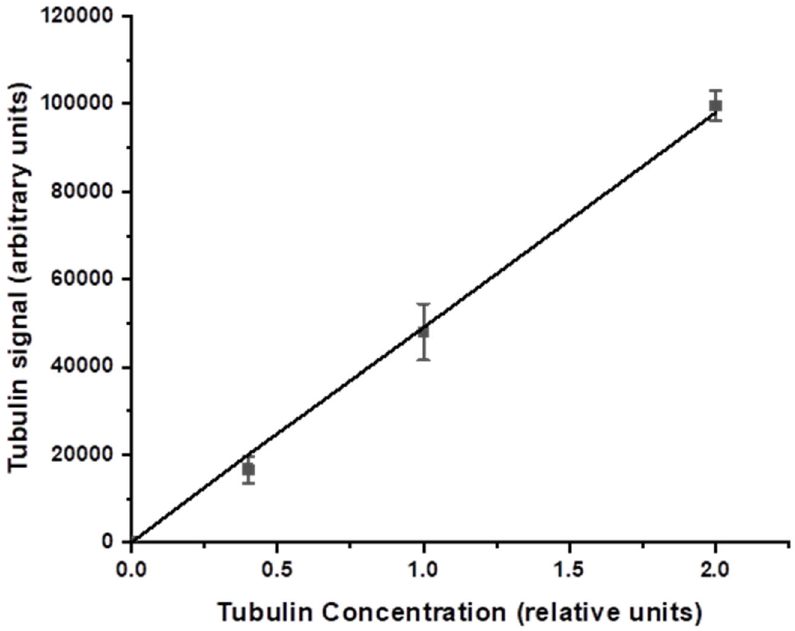
Figure 8. Western Blot signal as a function of tubulin concentration. The range of protein concentra ‐ tion for measuring the XPB, XPA and XPD levels in BRBE ‐ treated and untreated HeLa cells were performed within the linear protein concentration range shown in this graph.